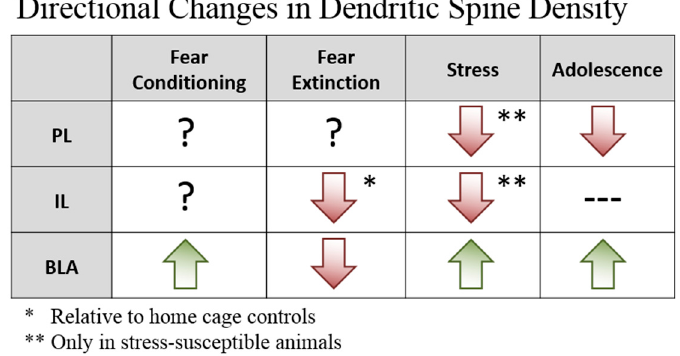
Figure 1. Summary of directionality of regional dendritic spine changes in response to fear conditioning, extinction, stress, and adolescence.